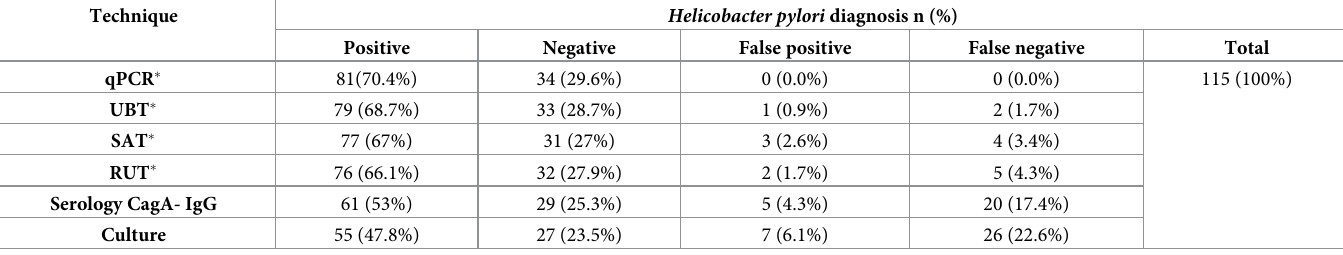
Table 3. The results of each Helicobacter pylori diagnostic test compared to